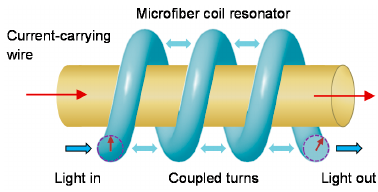
Figure 7. Schematic diagram of the microfiber coil resonator sensor head being interrogated by current. The directions of light propagation and mode coupling are shown as arrows. The arrows in dashed-circles represent the Faraday rotation.